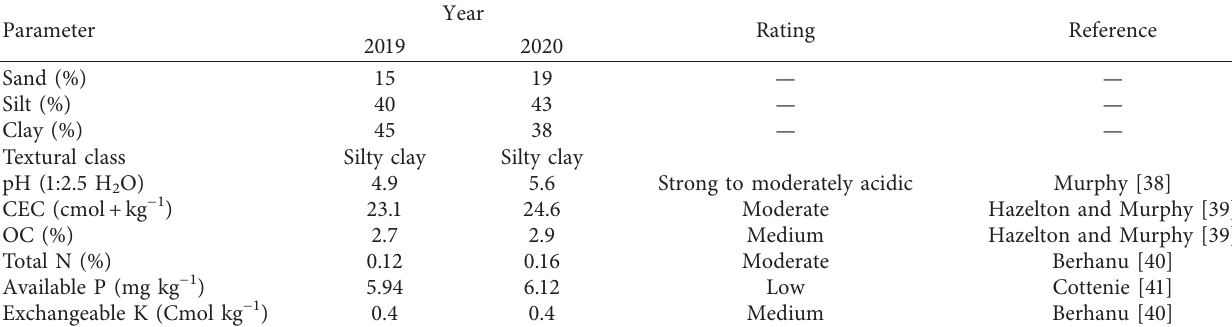
Table 2: Soil physical and chemical properties at the study site in Sodo Zuria District, southern